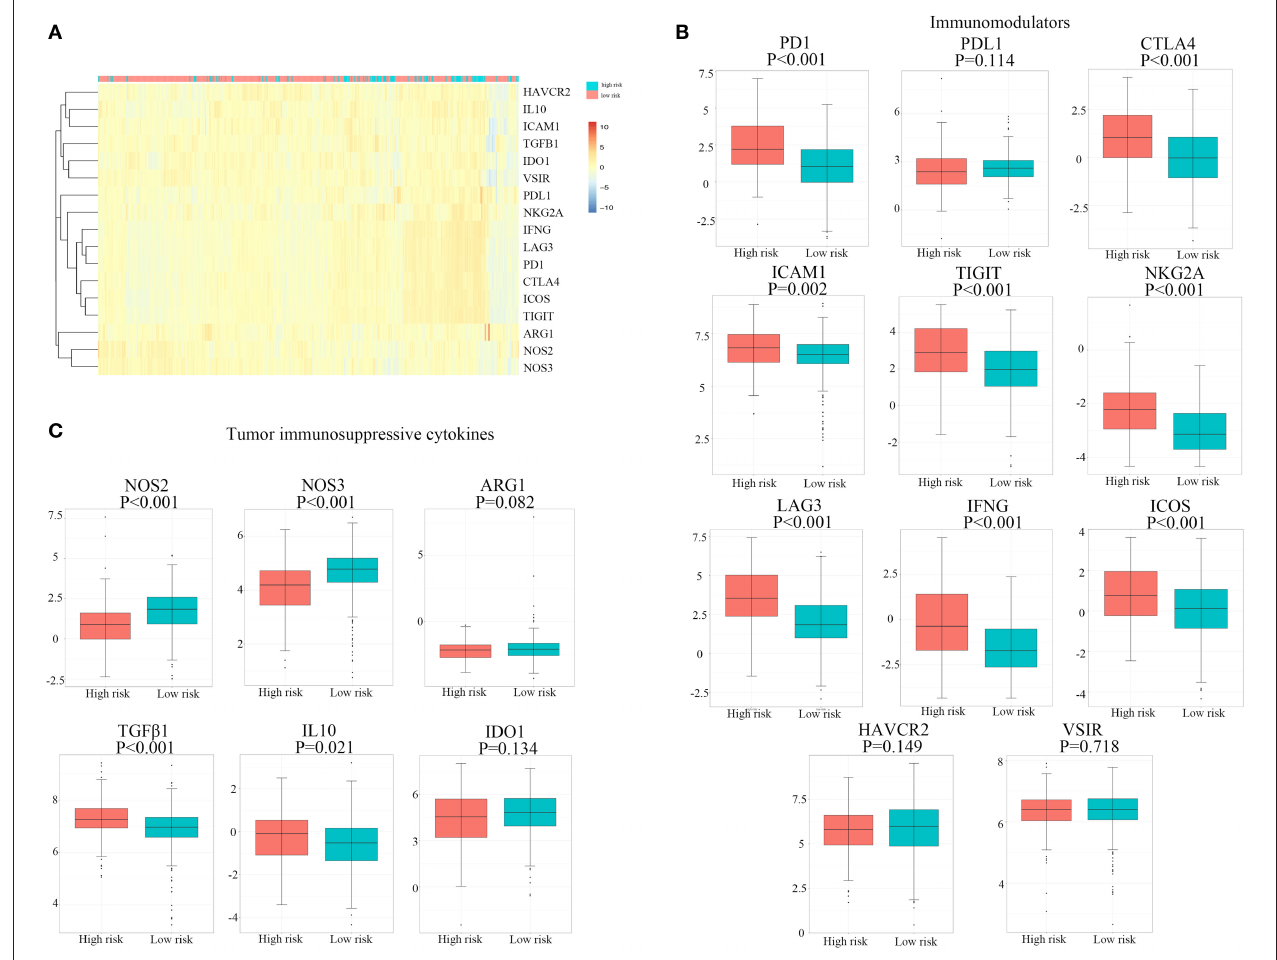
FIGURE 5 | Expression profile of immunomodulators and immunosuppressive cytokines. (A) Distribution of genes of immunomodulators and immunosuppressive cytokines. (B,C) The proportions of immunomodulators and immunosuppressive cytokines between high and low hypoxia risk groups in TCGA cohort. TCGA, The Cancer Genome